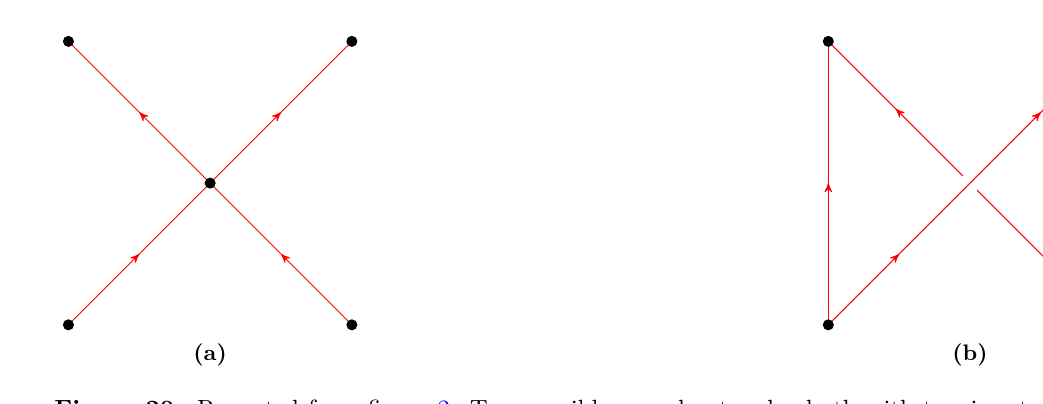
Figure 20. Repeated from figure 2. Two possible causal networks, both with two input and two output locations. a) Arbitrary tasks can be completed by bringing the input systems together at the central vertex. b) Arbitrary tasks can be completed on this network, but only when sufficient entanglement is shared between the input